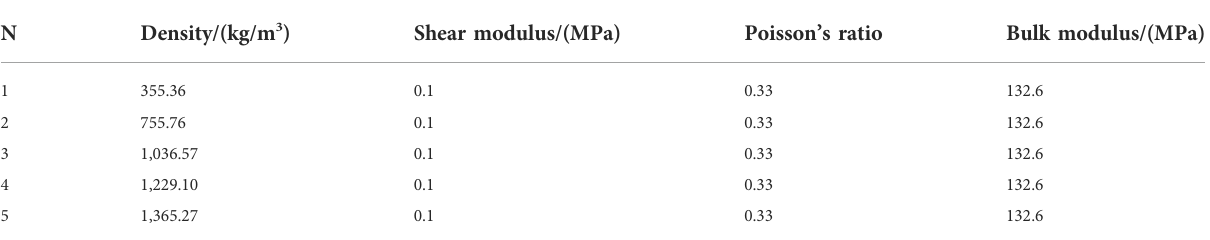
TABLE 3 Material distribution of the polyurethane underwater sound